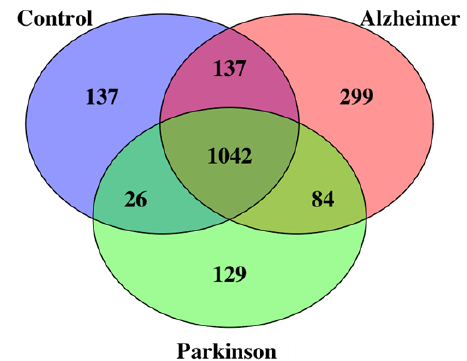
Figure 1. Venn diagram of proteins identified in CSF samples from the control, Alzheimer’s disease (AD) and Parkinson’s disease (PD) groups. Total number of identified antigens in all samples was 1854 with 1042 (56%) common antigens in all groups. Number of identified antigens in control, AD and PD groups were 1342, 1562 and 1281